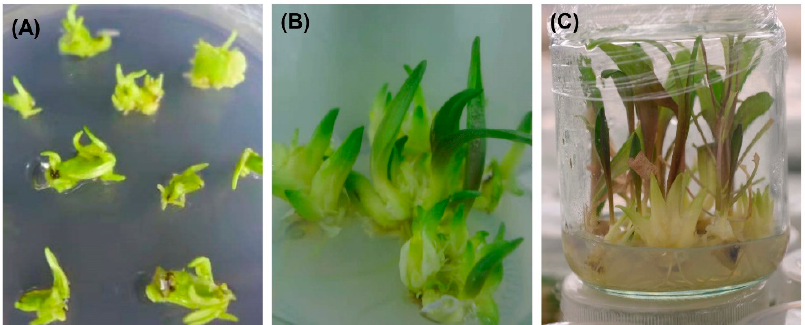
Figure 7. The tissue culture of F. thunbergii . ( A ). Callus induced from bulb section of F. thunbergii . ( B ). The redifferentiation of callus of F. thunbergii . ( C ). Tissue culture plantlets of F. thunbergii induced rooting.